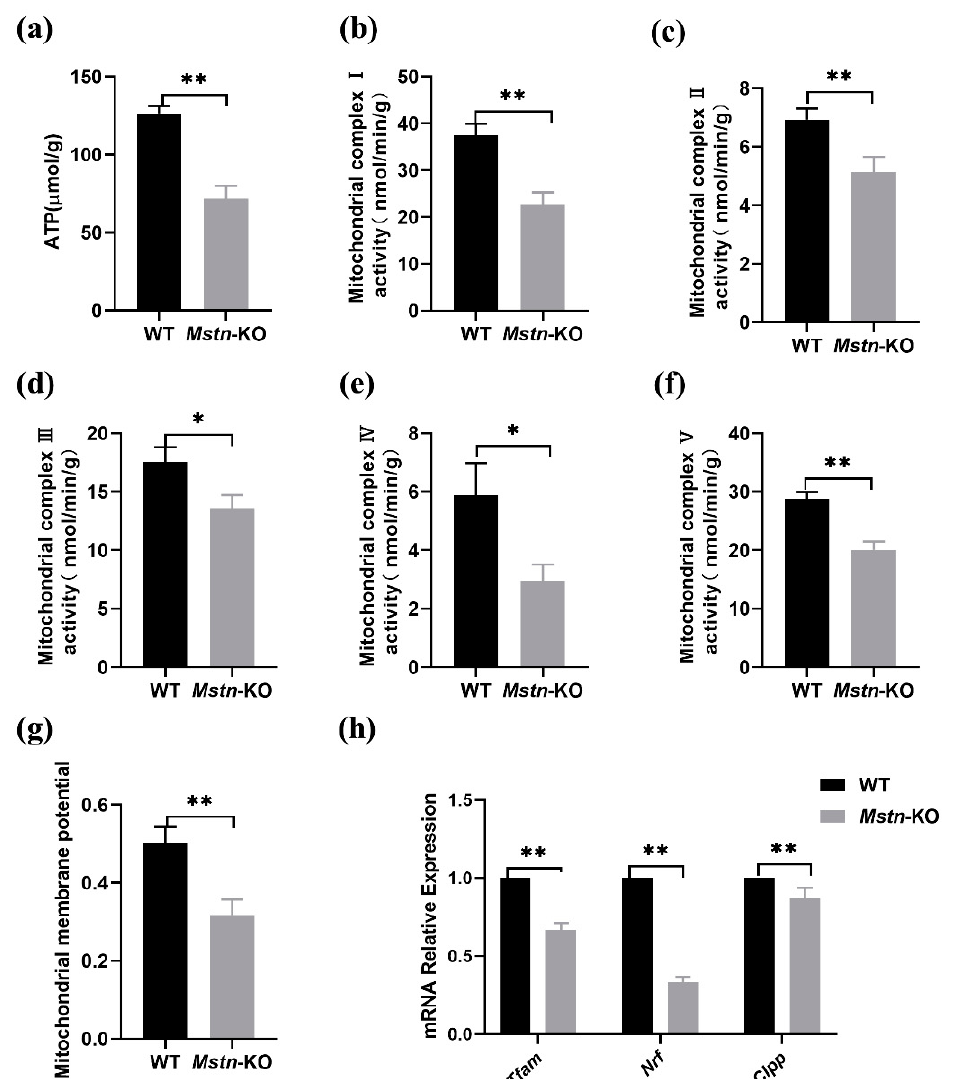
Figure 4. Mstn knockout reduced ATP content and mitochondria activity. ( a ) ATP content in Mstn -KO and WT mice muscle ( n = 3). ( b – f ) Mitochondrial complexes I–V activity was analyzed by biochemical detection ( n = 3). ( g ) Measurement of the mitochondrial membrane potential of Mstn -KO and WT mice ( n = 3). ( h ) mRNA levels of mitochondrial activity gene by qPCR ( n = 3). All data are presented as mean ± SD. * p < 0.05, ** p < 0.01; t-tests were used to calculate the p -values.